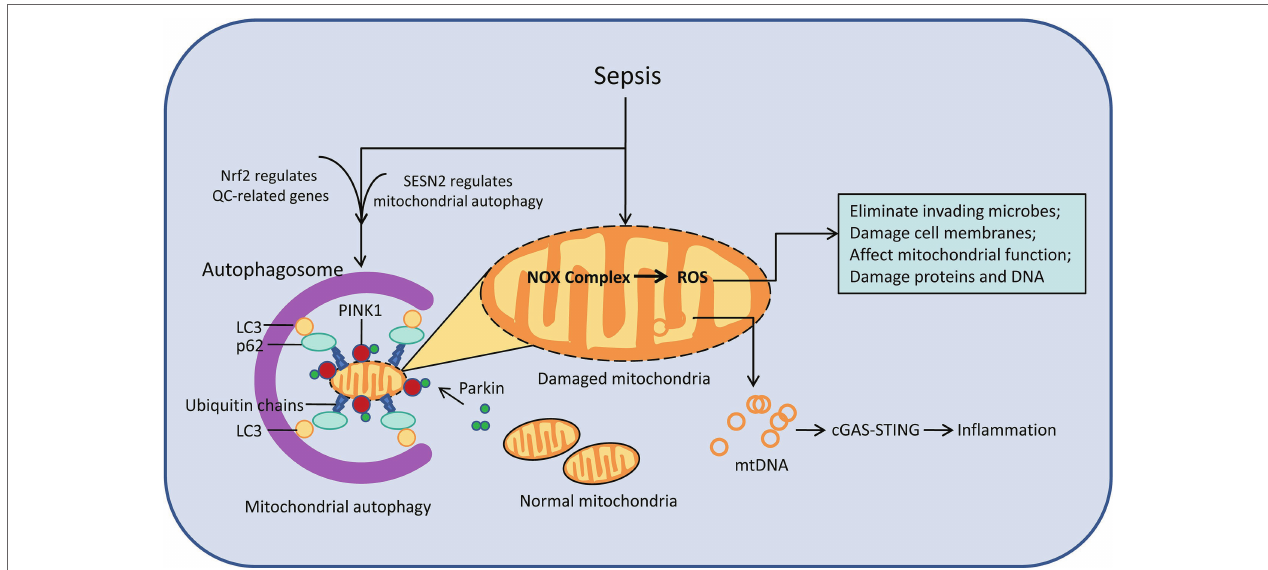
FIGURE 2 | Mitophagy and oxidative stress in damaged mitochondria. After the onset of sepsis, the number of damaged mitochondria increases. Damaged mitochondria cause mitochondrial dysfunction through ROS signaling pathways and mtDNA, causing a series of damage. Autophagy can remove damaged mitochondria. The process of autophagy is regulated by cytokines such as Nrf2 and SESN2. cGAS, cyclic GMP-AMP synthase; mtDNA, mitochondrial DNA; QC, quality control